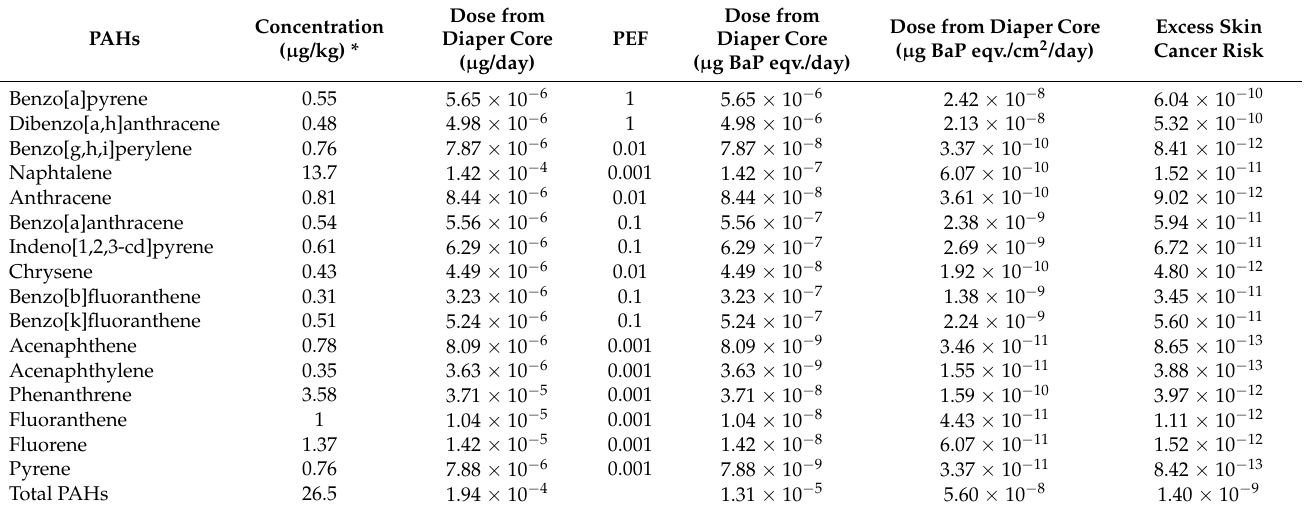
Table 1. Excess skin cancer risks of polycyclic aromatic hydrocarbons (PAHs) in the diaper core.